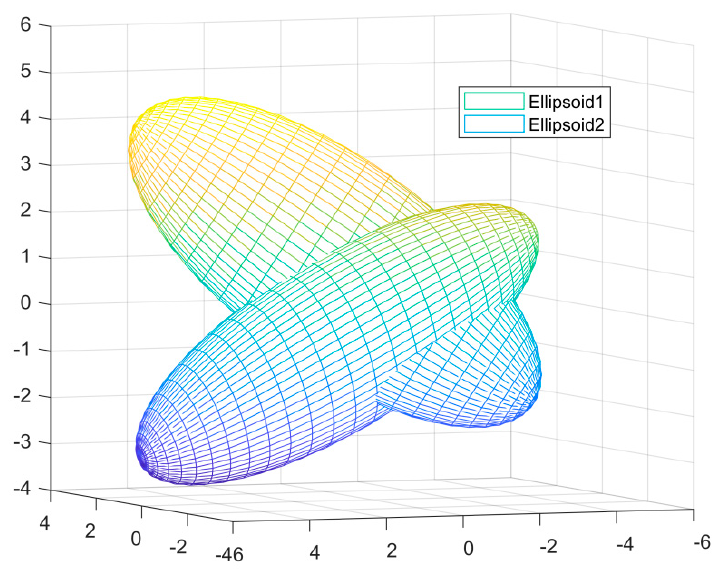
Figure 4. Ellipsoid1 and Ellipsoid2 forms of two locally estimated ( 𝑥 (cid:2869) , 𝑥 (cid:2870) ) under the sublevel set